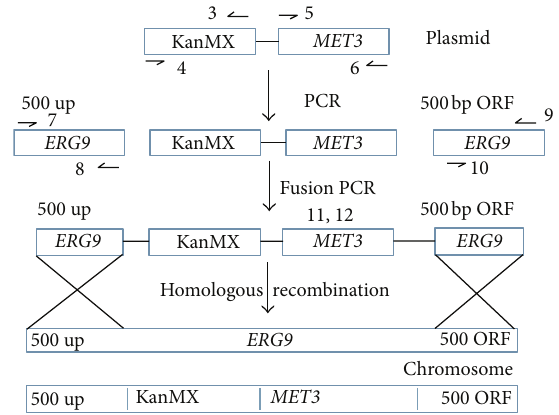
Figure 1: Promoter replacement of ERG9 gene by using bipartite gene fusion